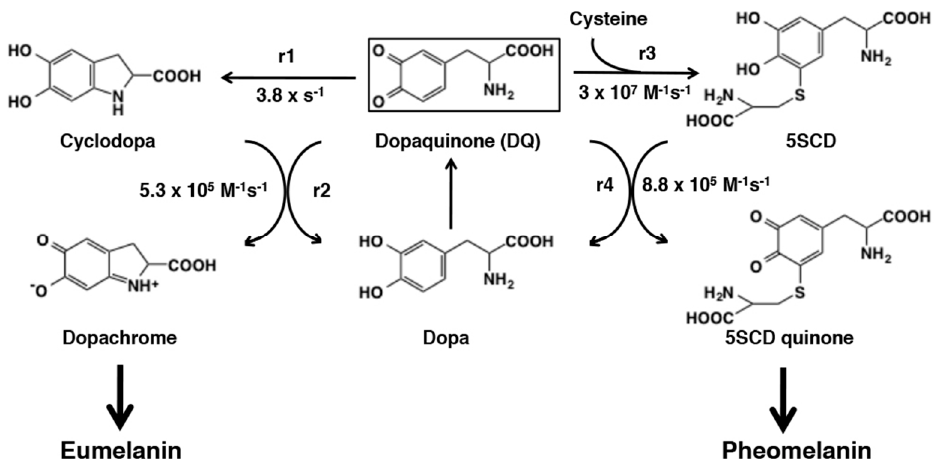
Figure 27. Kinetics of early stages of mixed melanogenesis. Note that the rate constants r1–r4 are controlled by the intrinsic chemical reactivity of dopaquinone (DQ) [17,148–150].